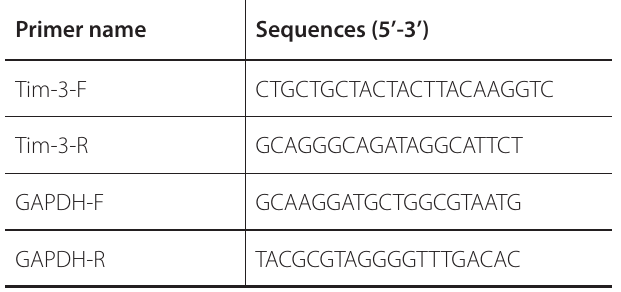
Table 1 . Primer sequences used in this study.